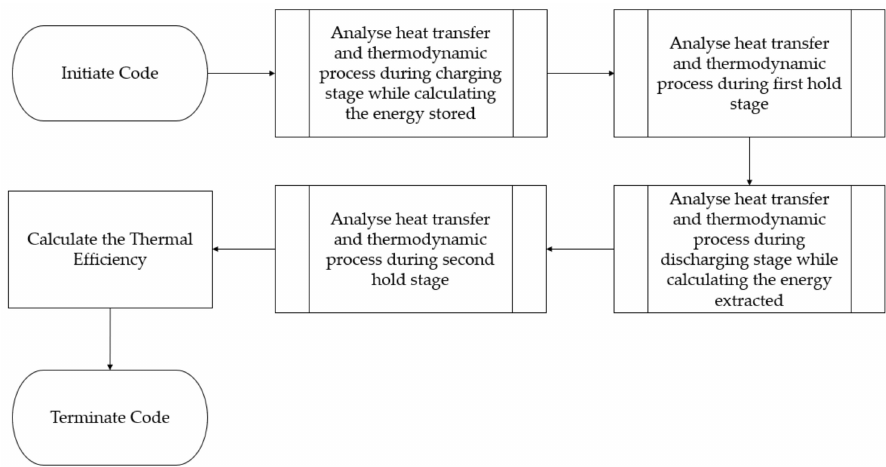
Figure 4. Flow followed by both air-based and CO 2 -based HPES